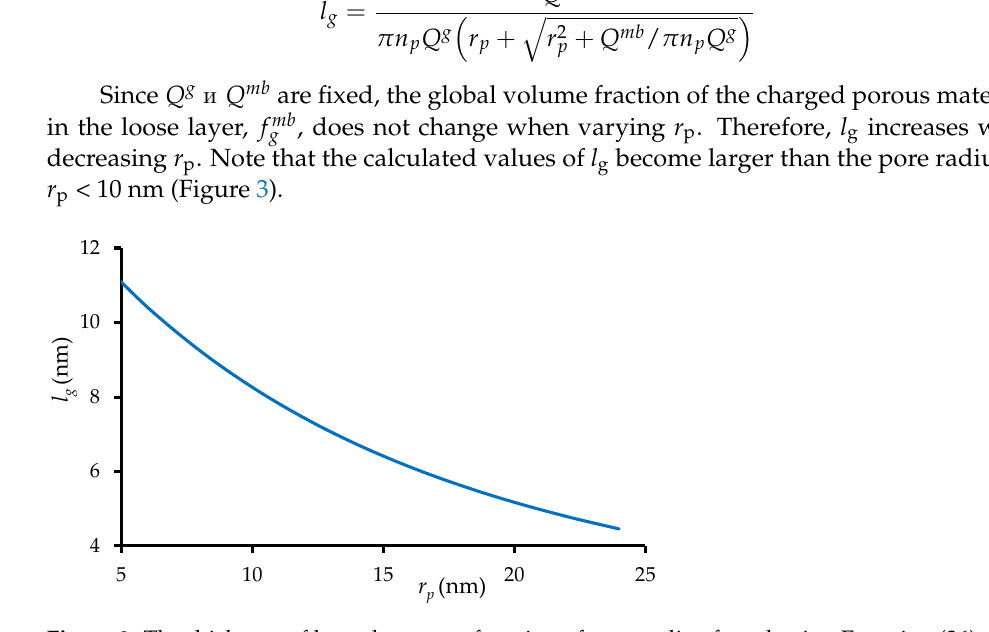
Figure 3. The thickness of loose layer as a function of pore radius found using Equation (26) with n p = 5.0 × 10 9 pores/cm 2 , Q g and Q mb are indicated in Table 2.